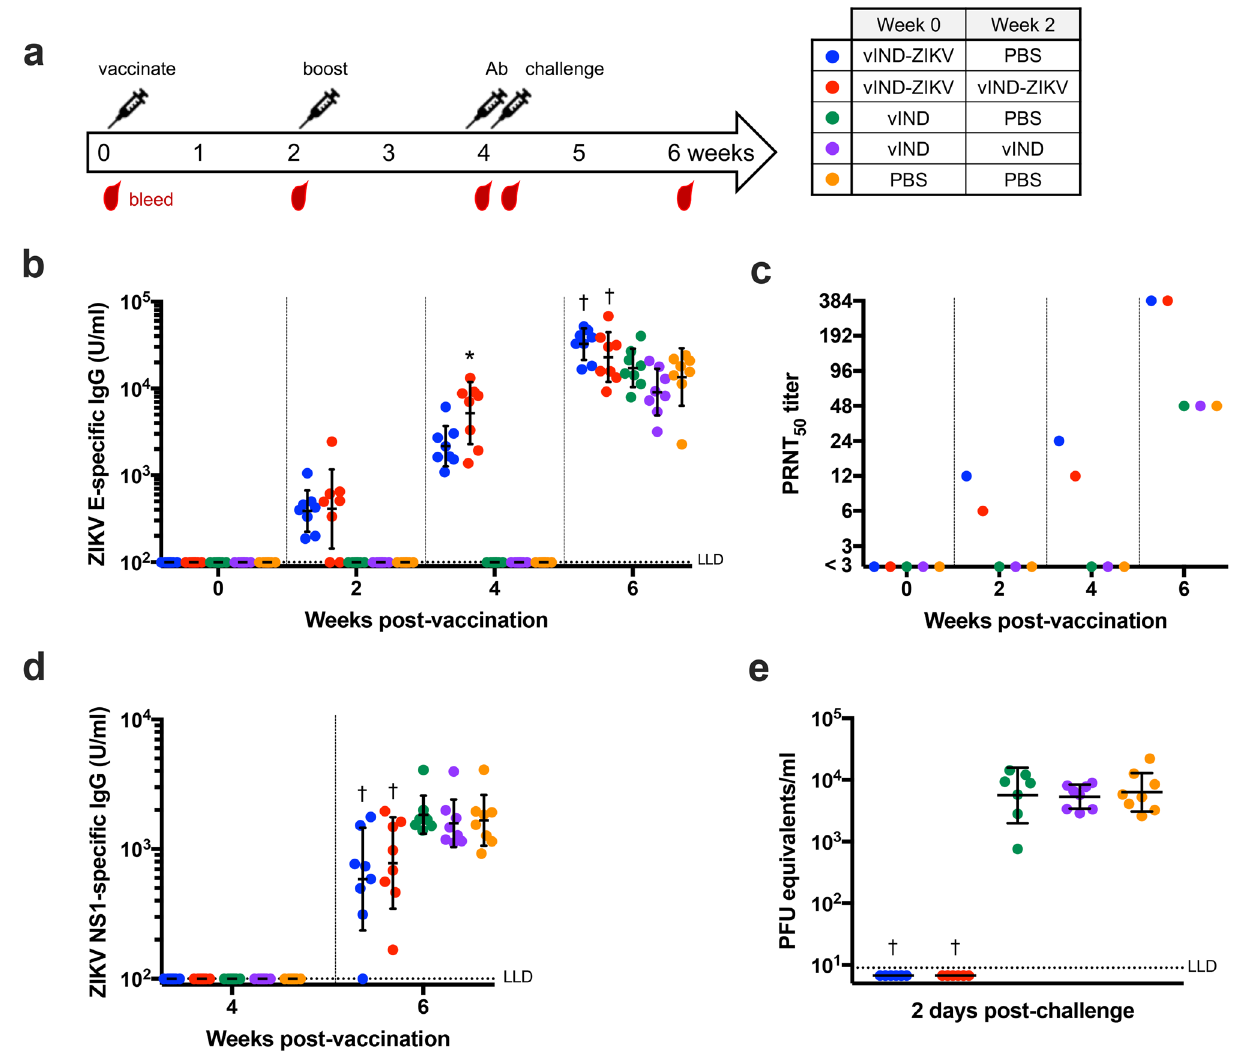
Figure 5. A single vaccination with vIND-ZIKV is protective in mice. ( a ) Schematic of vaccination/challenge schedule and timing of blood collection. Six-week-old immunocompetent C57BL/6 mice (n = 8) were vaccinated intramuscularly with PBS or 10 7 PFU vIND or vIND-ZIKV (D4W) at weeks 0 and 2. Mice were challenged 2 weeks post-boost with 10 4 PFU ZIKV strain PRVABC59 intraperitoneally, 1 day after being administered 2 mg anti-IFNAR1 antibody intraperitoneally. ( b ) ZIKV E-specific IgG titers were measured by ELISA at weeks 0, 2, 4 (1 day prior to challenge), and 6. ( c ) PRNTs were performed in twofold dilutions on pooled serum collected at the indicated time points. ( d ) ZIKV NS1-specific IgG titers were measured by ELISA at weeks 4 (1 day prior to challenge) and 6. ( e ) Viremia was measured in serum collected 2 days after ZIKV challenge by qRT-PCR. Asterisks represent statistical significance (*p < 0.05, † p < 0.005) by two-way repeated measures ANOVA ( b , d ) or unpaired t tests ( e ) compared to PBS-vaccinated control group. Horizonal lines represent geometric mean and error bars represent SD. LLD lower limit of